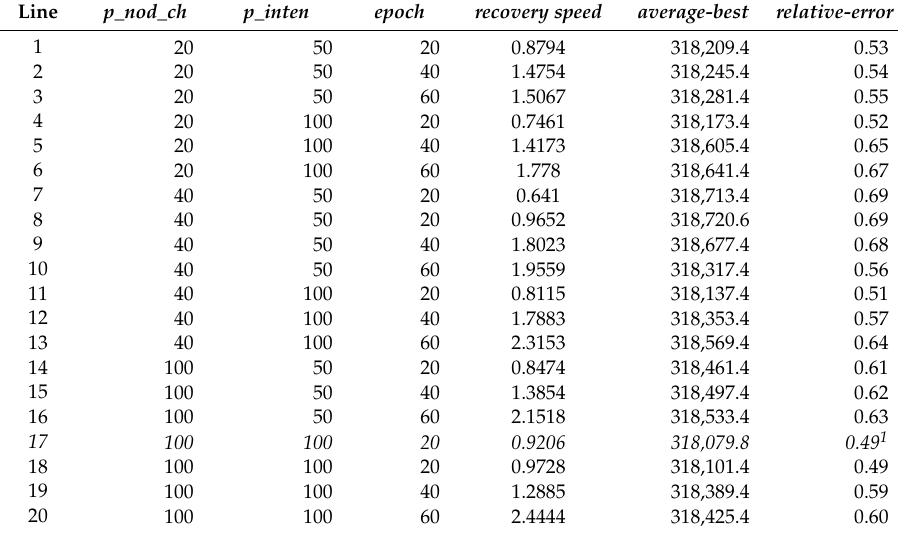
Table 7. Parameters and metrics for rl1889 , with ampl = 40.